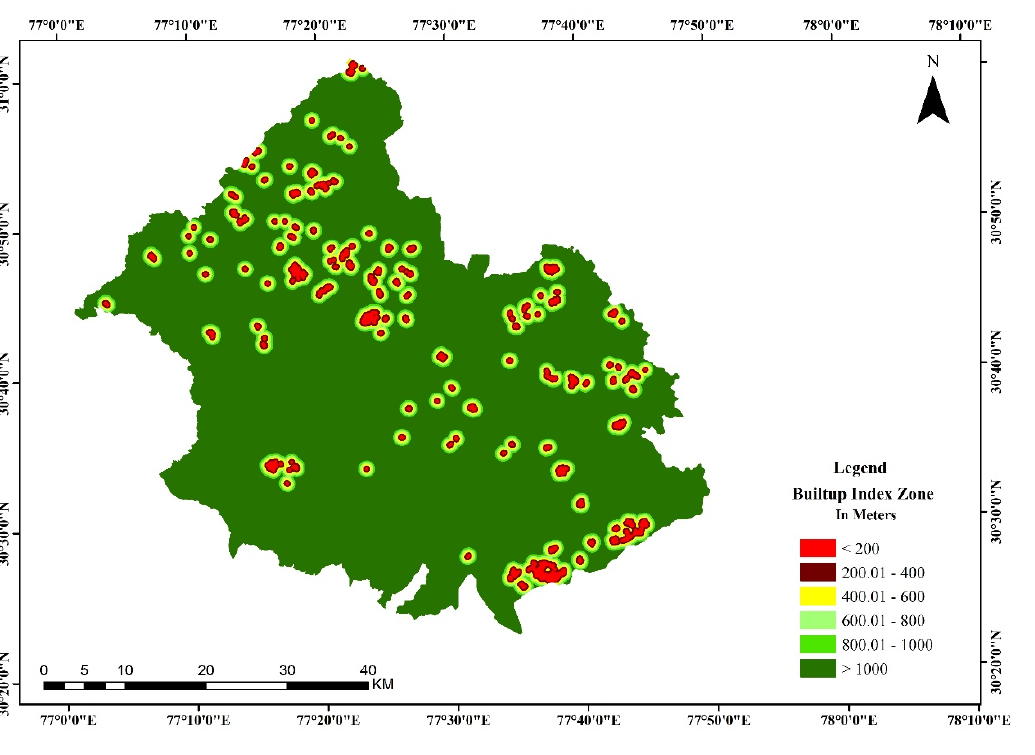
Figure 9. Built up buffer risk index.